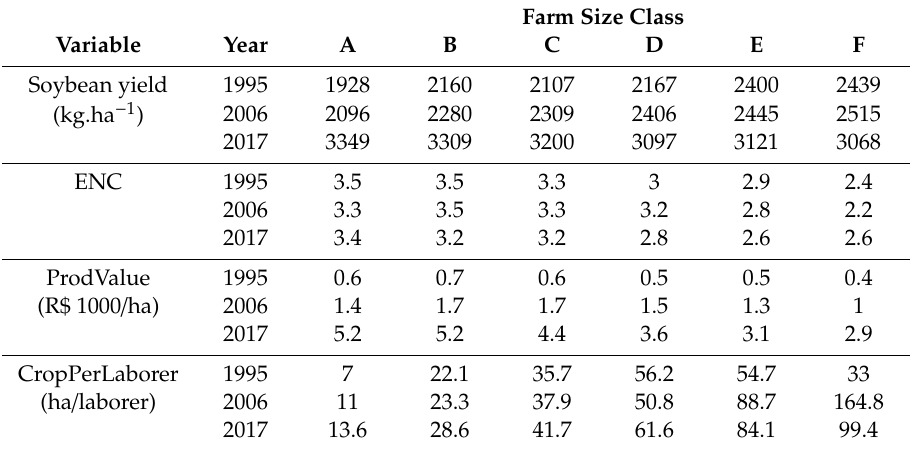
Table 3. Mean values for variables according to municipality classes of soybean farm